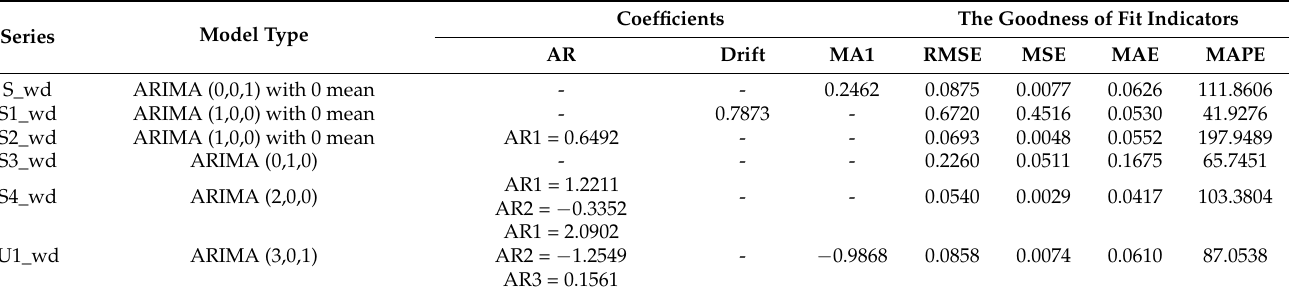
Table 23. ARIMA models for detrended weekly series S_wd, S1_wd, S2_wd, S3_wd, S4_wd, and U1_wd.